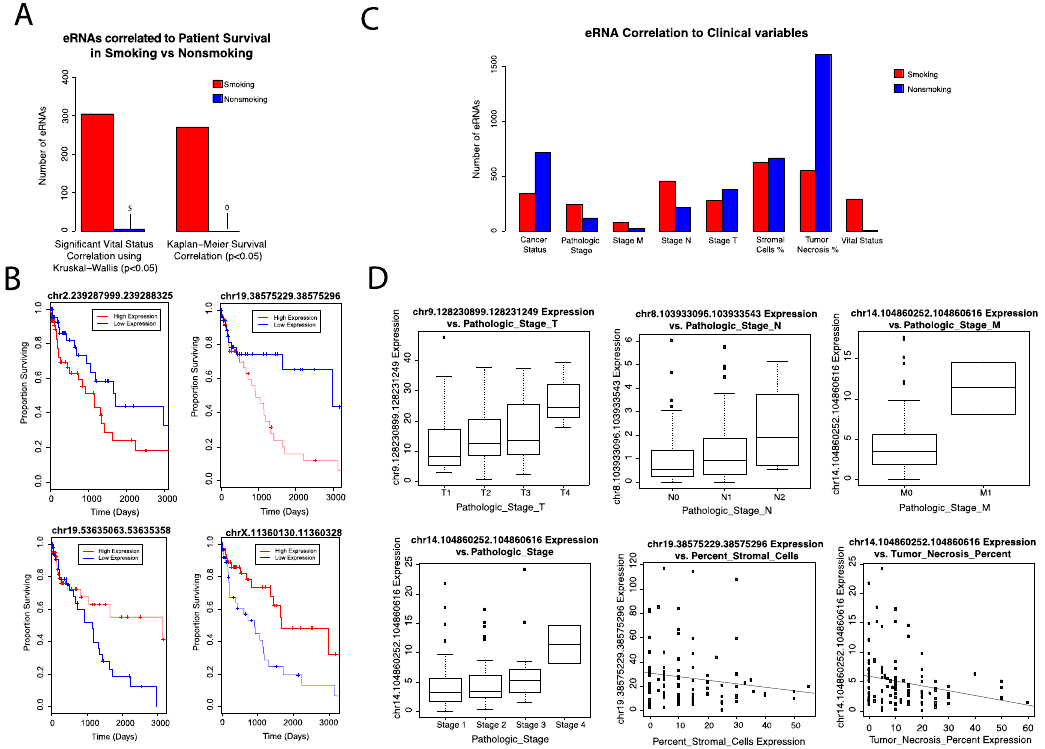
Figure 2. Correlation to Clinical Variables and Patient Survival. ( A ) The total amount of eRNAs identified to be correlated to patient survival and vital status in smoking-onset LUSC and nonsmoking-onset LUSC. Red correlates to smoking-onset LUSC data, and blue correlates to nonsmoking-onset LUSC data. Overall, there was a significantly greater amount of eRNAs associated with patient survival and vital status in the smoking-onset LUSC cohort. ( B ) Select cox proportional hazards regression plots (Kaplan–Meier) of patient survival rates (in days) in correlation to eRNA expression. ( C ) Bar graph representing the total significant correlations between eRNA expression and several clinical variables in both the smoking-onset LUSC cohorts and the nonsmoking-onset LUSC cohorts. Clinical variables investigated include tumor necrosis, cancer status, cancer pathological stage, cancer pathological m stage, cancer pathological n stage, cancer pathological t stage, stromal cell expression, and cancer vital status. ( D ) Select boxplots and scatterplots of eRNAs significantly correlated to clinical variables, including pathological stage T, pathological stage n, pathological stage m, tumor stromal cells, tumor necrosis, and tumor pathological stages 1, 2, 3, and 4. Boxplots plots were created using the Kruskal–Wallis test, while the scatterplots were created using the Spearman test, and all plots were filtered by p -value ( p -value <0.05). The various correlations in the plots suggest that the upregulation of eRNAs identified from previous analyses are associated with advanced cancer pathological stage and are negatively correlated with tumor stromal cells and tumor necrosis percent expression.